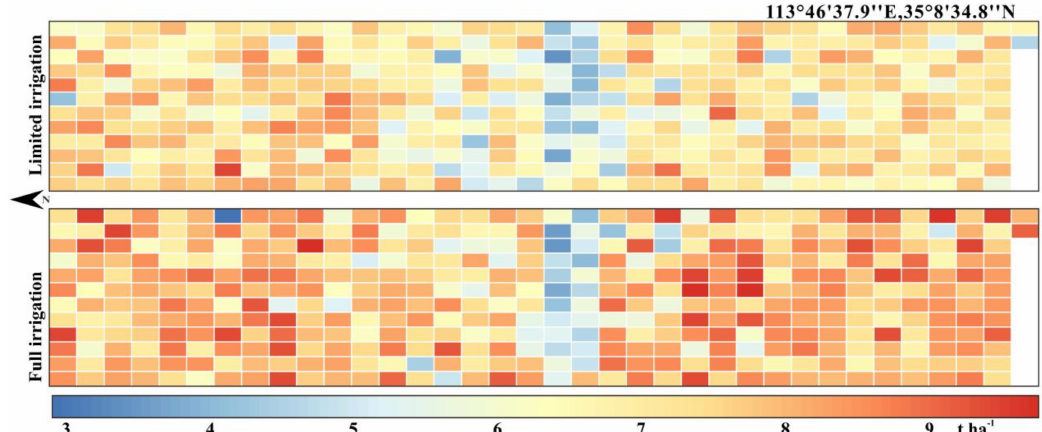
Figure A3. Spatial distribution of grain yield (t ha − 1 ) at the plot scale using an ensemble learning